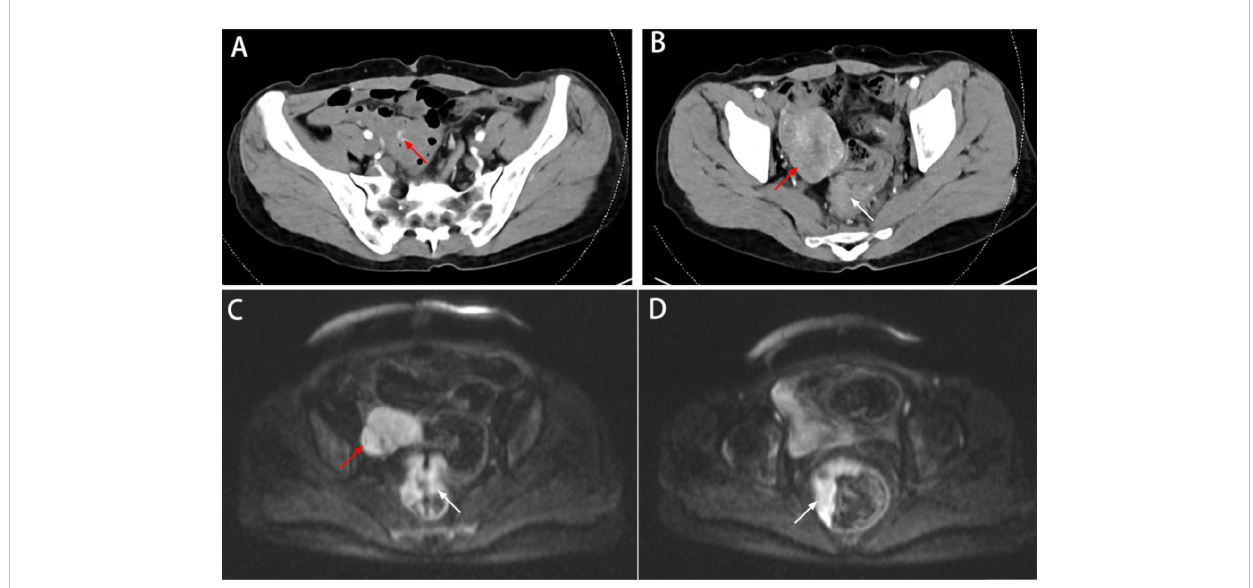
FIGURE 1 Preoperative imaging data. (A) CT showed the blood supply of the tumor originating from the branches of the SMA (red arrow). (B) CT showed a soft tissue mass on the right side of the pelvis (red arrow); the wall of the middle and lower rectum was thickened, with mild enhancement (white arrow). (C, D) MRI showed a mass in the pelvis (red arrow); the rectal lesion appeared hyperintense on DWI (white